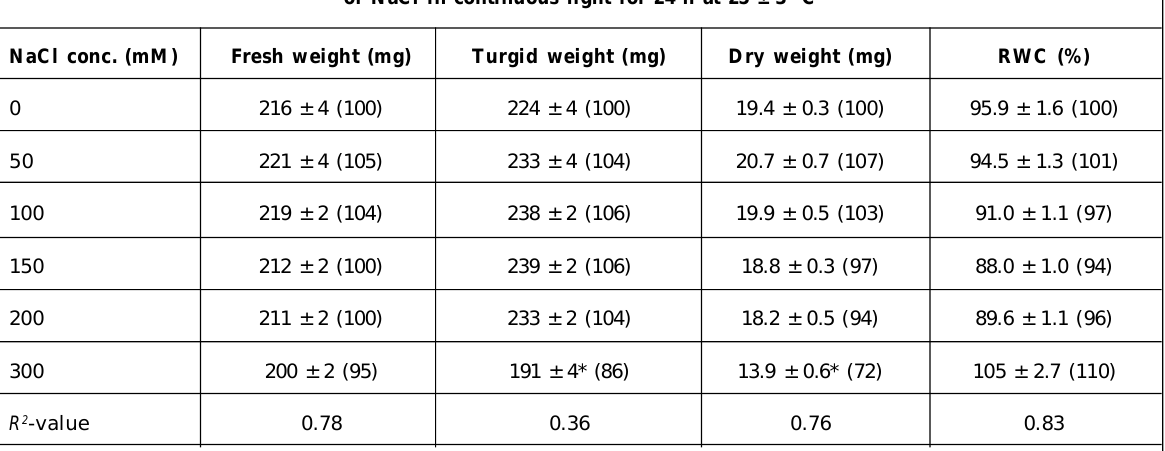
Table 3: Effect of salt stress imposed by using NaCl on fresh weight, turgid weight, dry weight and relative water content in etiolated maize leaf segments during greening Leaf segments from dark grown maize seedlings were treated with varying concentrations of NaCl in continuous light for 24 h at 25 ± 3 °C NaCl conc. (mM) Fresh weight (mg) Turgid weight